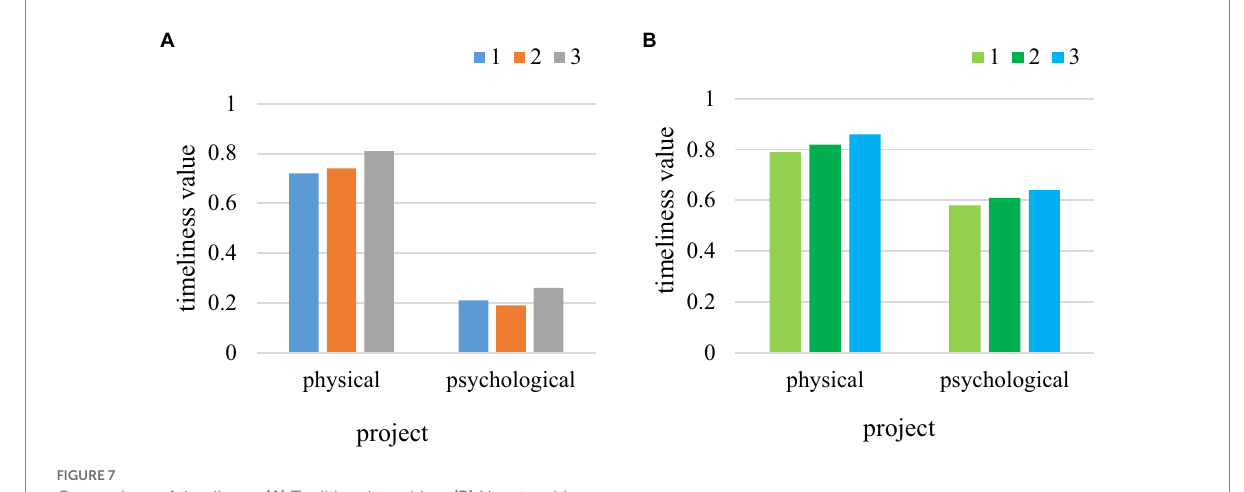
FIGURE 7 Comparison of timeliness. (A) Traditional teaching. (B) New